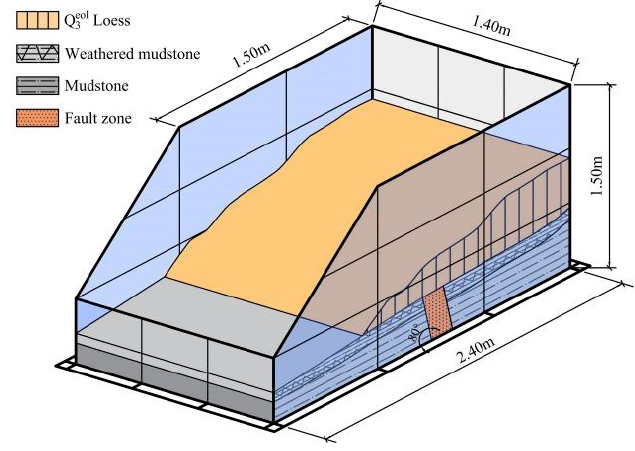
Figure 2. Schematic diagram of the model slope with model box (unit: m).